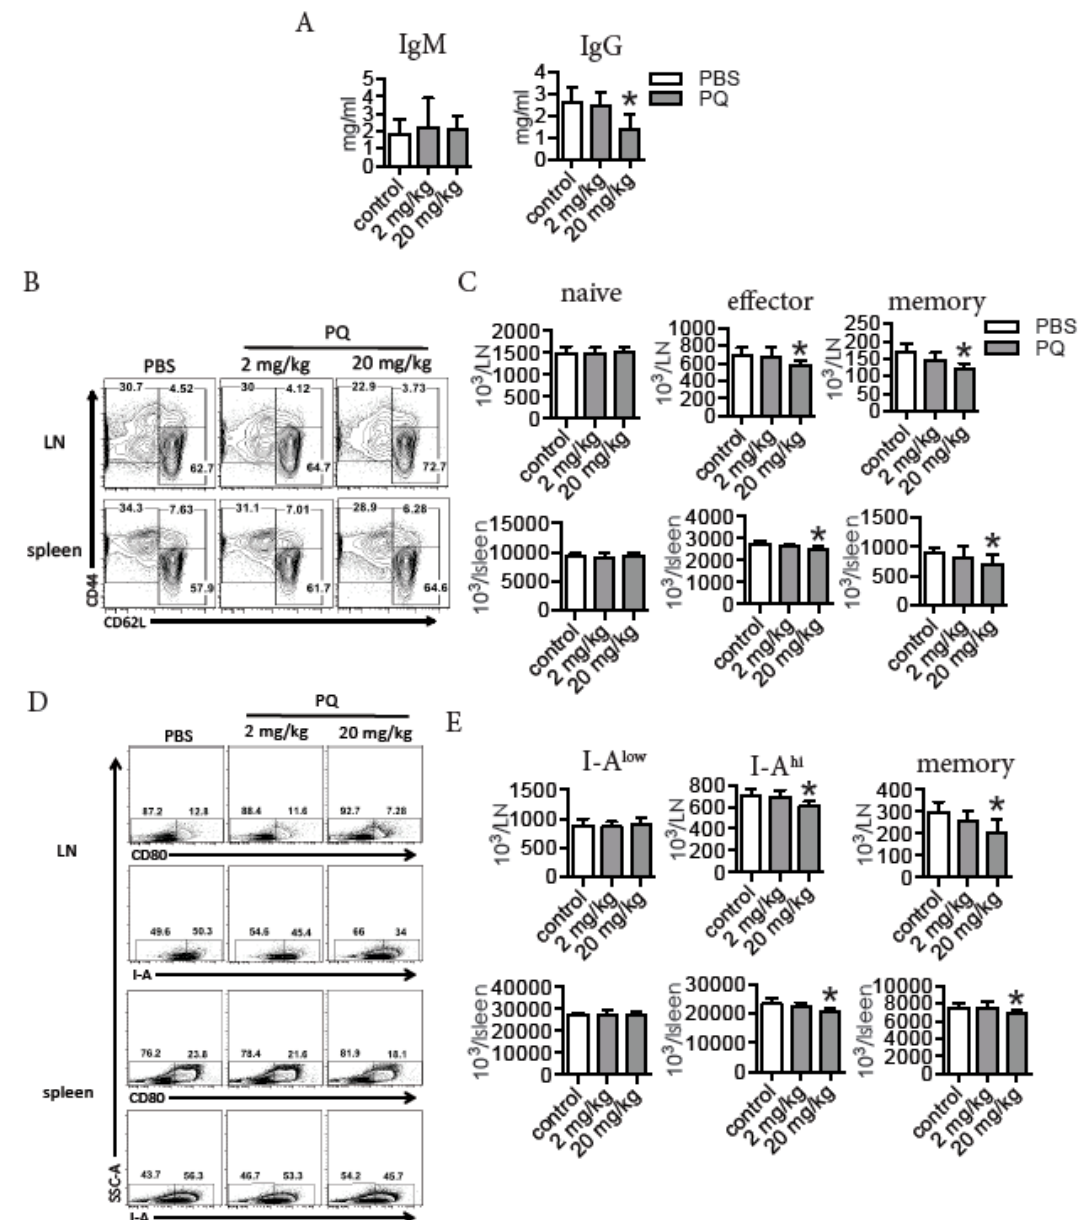
Figure 1. Paraquat (PQ) reduced the level of serum IgG and selectively decreased the number of e ff ector and memory lymphocytes during steady state. B6 mice were treated with PQ for 2 wks and thereafter serum antibodies and CD4 T cells and B cells in the LN and spleen were measured. ( A ) Serum IgM and serum IgG. ( B ) Representative flow plots for naïve (CD62L + CD44 − ), e ff ector (CD62L − CD44 + ) and memory (CD62L + CD44 + ) CD4 T cells in the LN and spleen; CD4 T cells were gated on CD3 + CD4 + cells. ( C ) Quantification of naïve, e ff ector and memory CD4 in the LN and spleen as indicated in B. ( D ) Representative flow plots for I-A low (CD80 − I-A low ), I-A hi (CD80 − I-A hi ) and memory (CD80 + ) B cells in the LN and spleen; B cells were gated on CD19 + cells. ( E ) Quantification of I-A low , I-A hi and memory B cells in LN and spleen as indicated in D. A total of 6 to 7 mice were used for each group. Asterisk indicates a significant di ff erence compared to the counterpart control group.